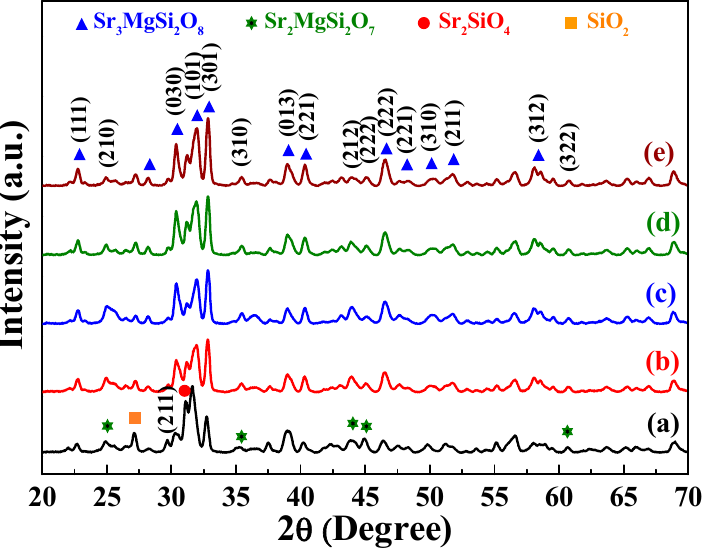
Figure 9. XRD patterns of the [Sr 0.99 Eu 0.01 ] 3 MgSi 2 O 8 phosphors sintered at different temperatures: ( a ) 1200, ( b ) 1250, ( c ) 1300, ( d ) 1350, and ( e ) 1400 °C. (a) 1200, (b) 1250, (c) 1300, (d) 1350, and (e) 1400 ◦